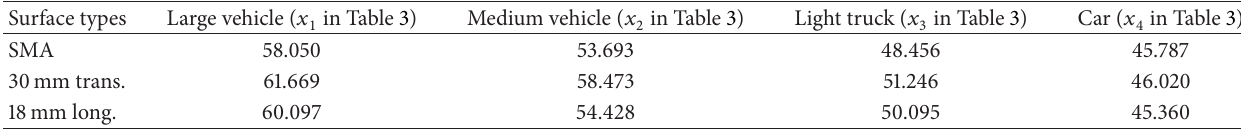
Table 5: Determination of the model coefficients via the HS algorithm.